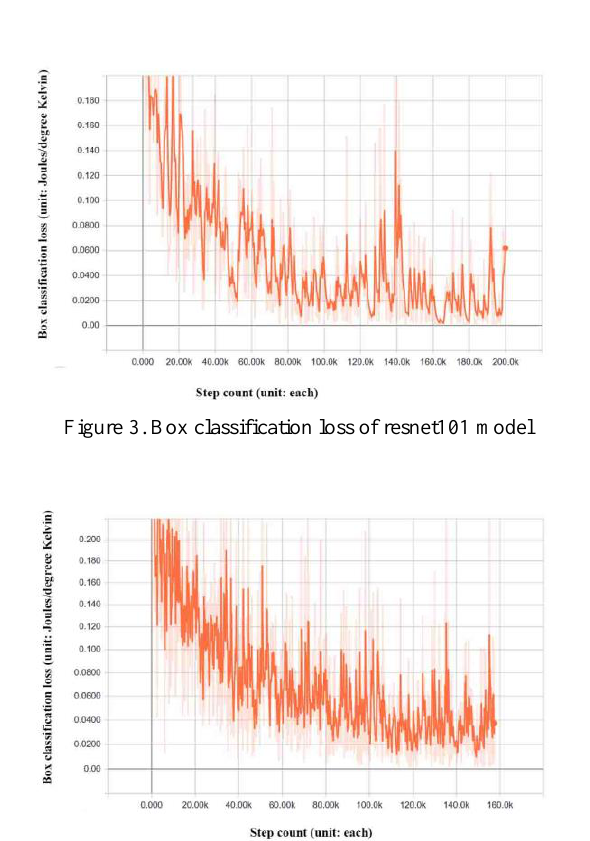
Figure 4. Box classification loss of resnet-v2 model